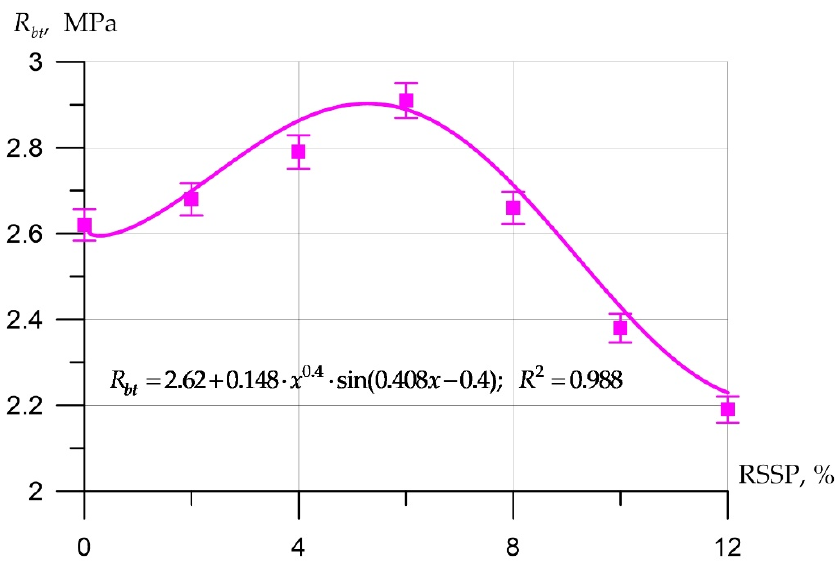
Figure 7. Axial tensile strength of snail shell powder concrete.